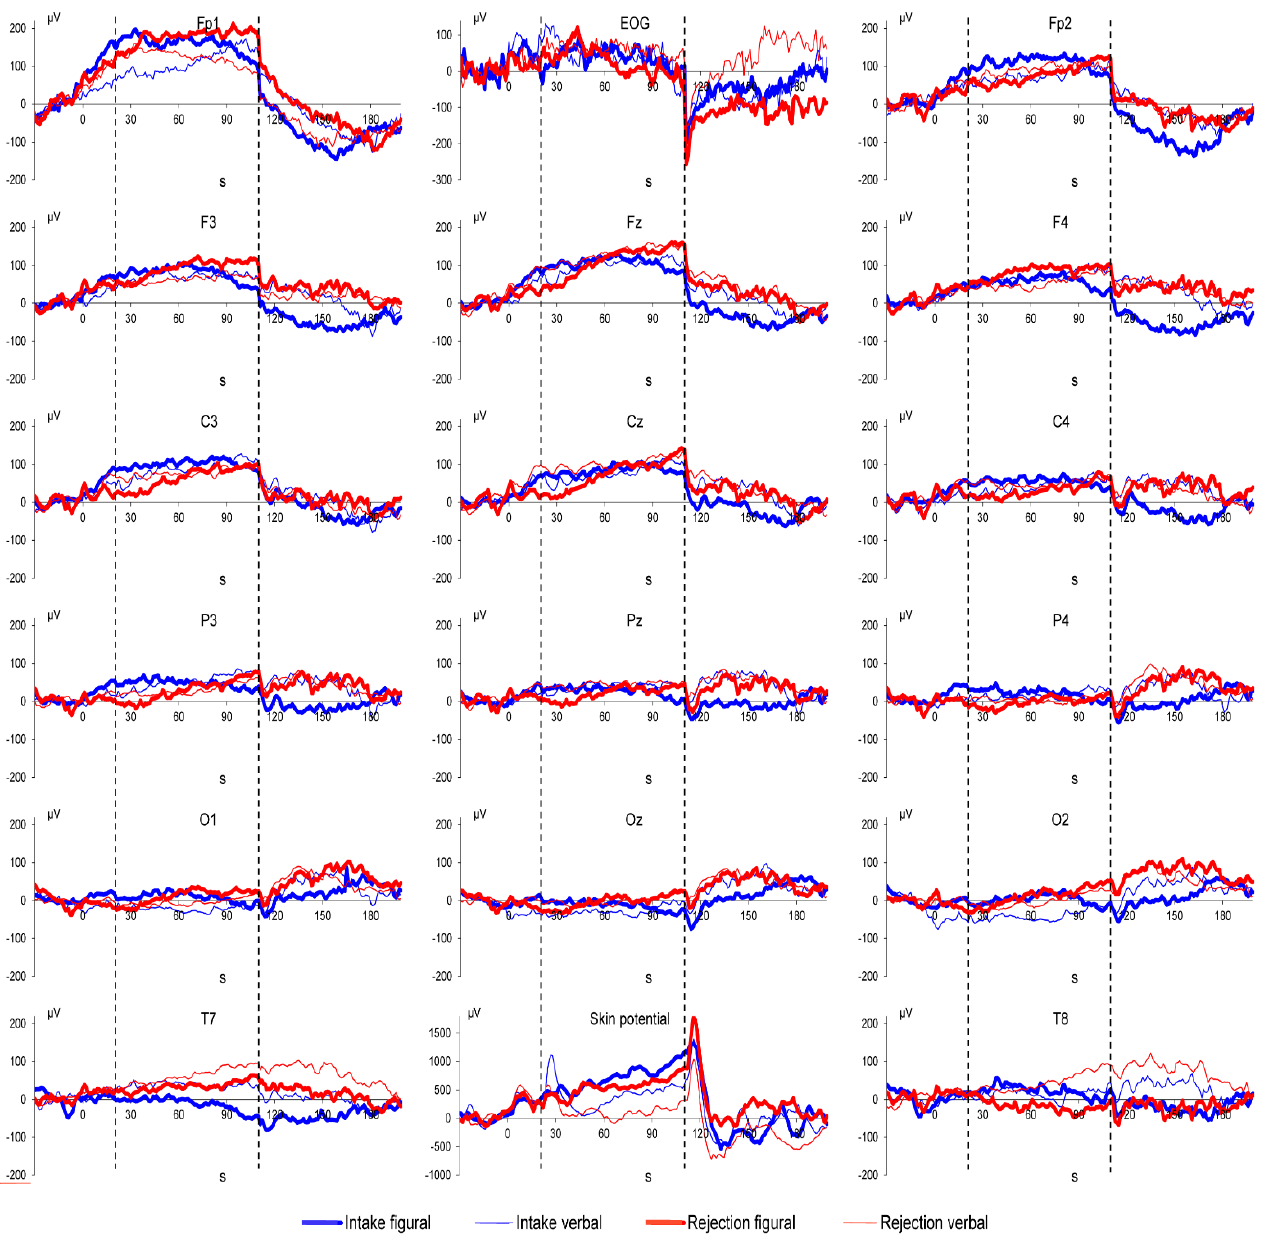
Figure 2. Irrelevant speech condition: Grand means of brain DC potentials (positivity upward) as well as vertical EOG and skin potential for the four attention task conditions. The timeline indicates when instruction (seconds 1–20), attention tasks (seconds 21–110; between the vertical broken lines), and examination of task execution (seconds 111–200) took